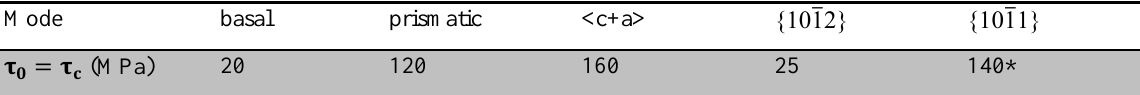
Material parameters inputs for the VPSC-PTR model. Mode basal prismatic <c+a> {101 ̅ 2}